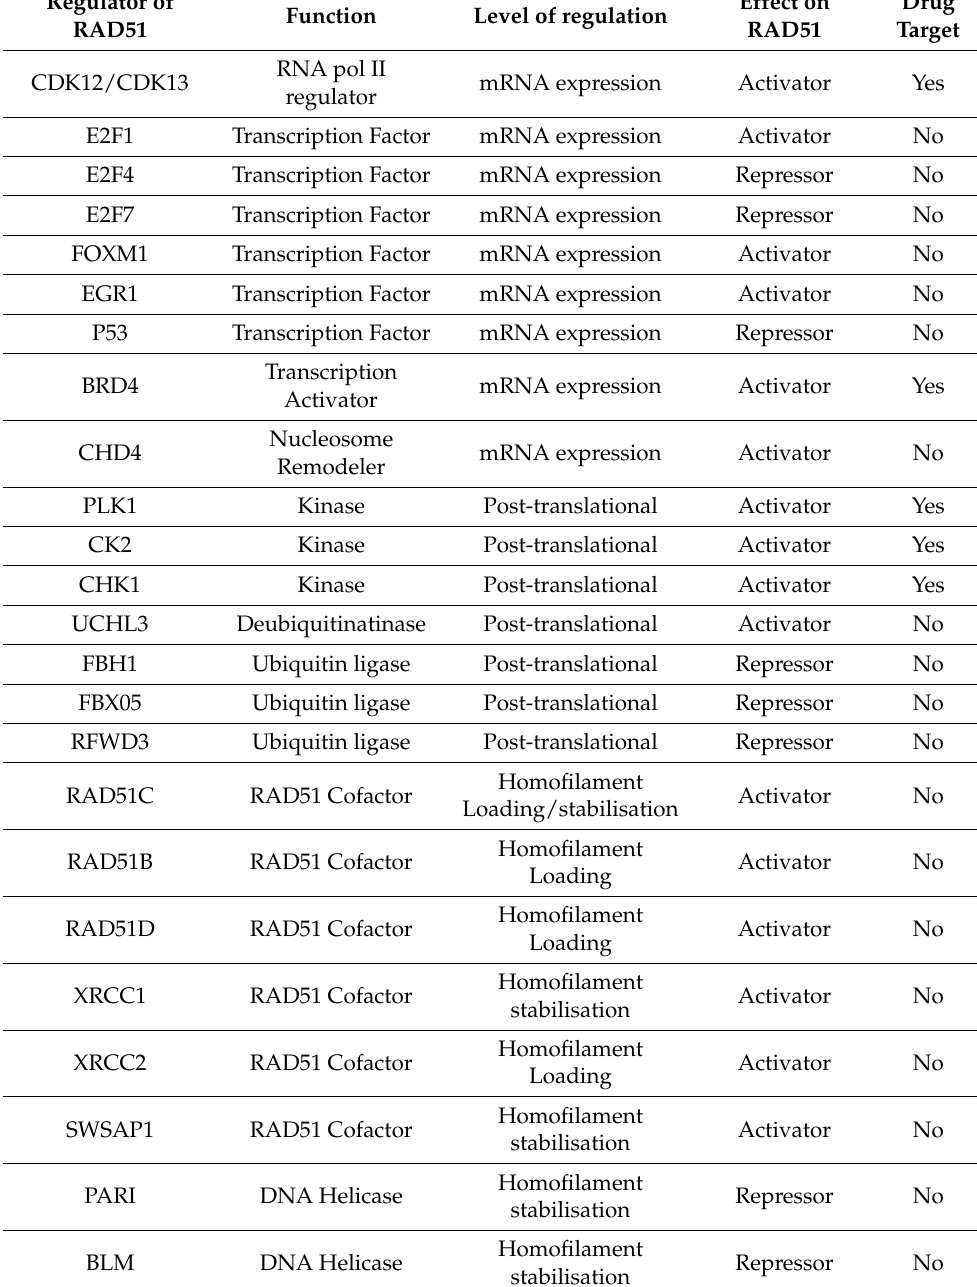
Table 1. Regulators of RAD51 at the transcriptional and post-translational levels. Abbreviation: RNA polymerase II (RNA pol